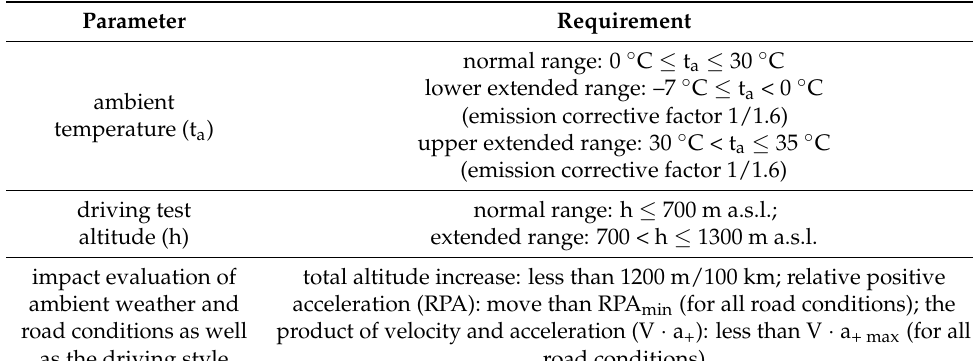
Table 2. Specific requirements of the RDE test